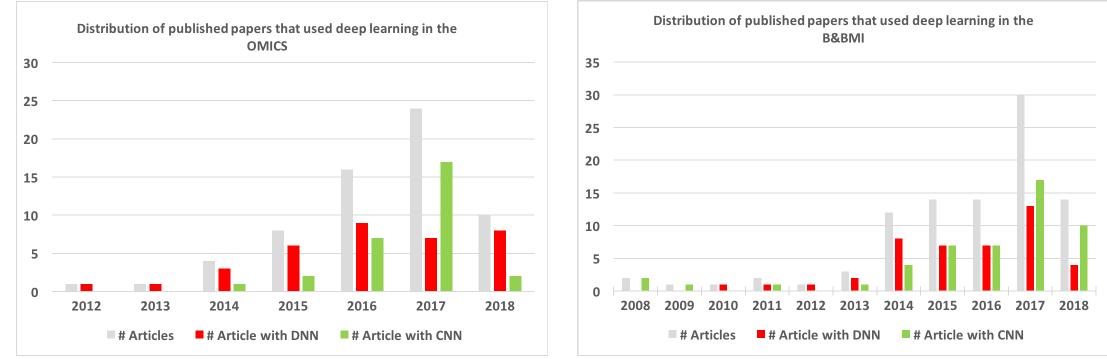
Figure 11. Distribution of papers reviewed in this